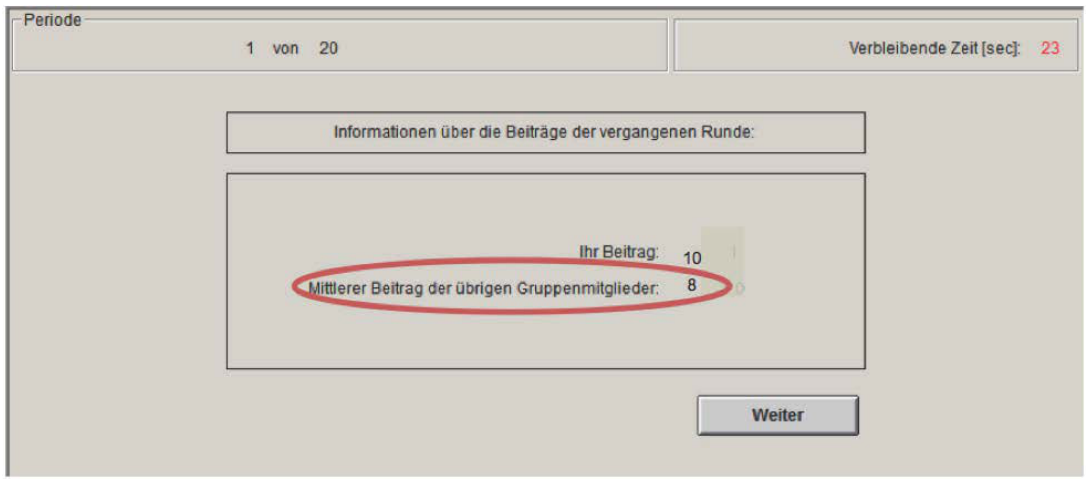
Figure A1. Screenshot–contribution